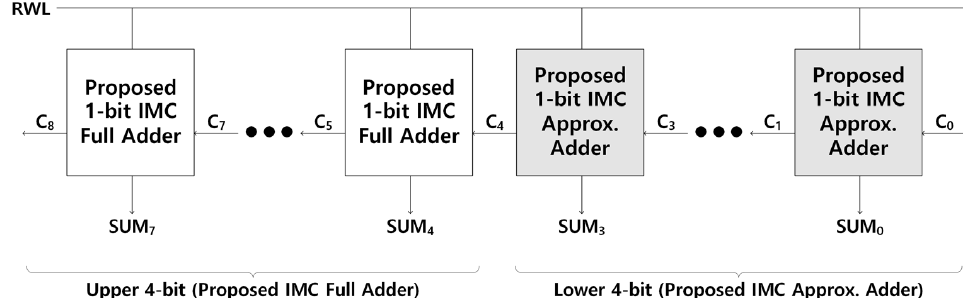
Figure 8. Diagram of the proposed 8 ‐ bit IMC approximate adder.